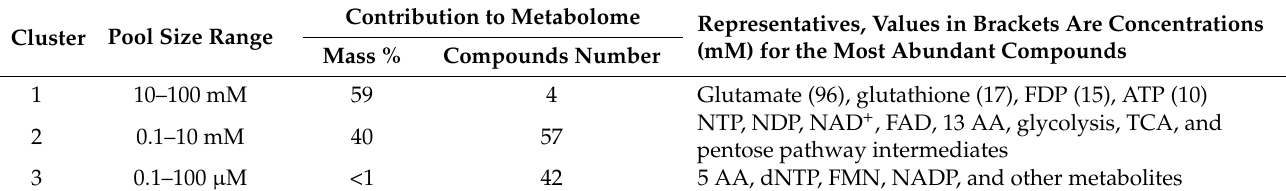
Table A2. Summary of the metabolomic analysis of E. coli grown on glucose, based on Reference [145]. Cluster Pool Size